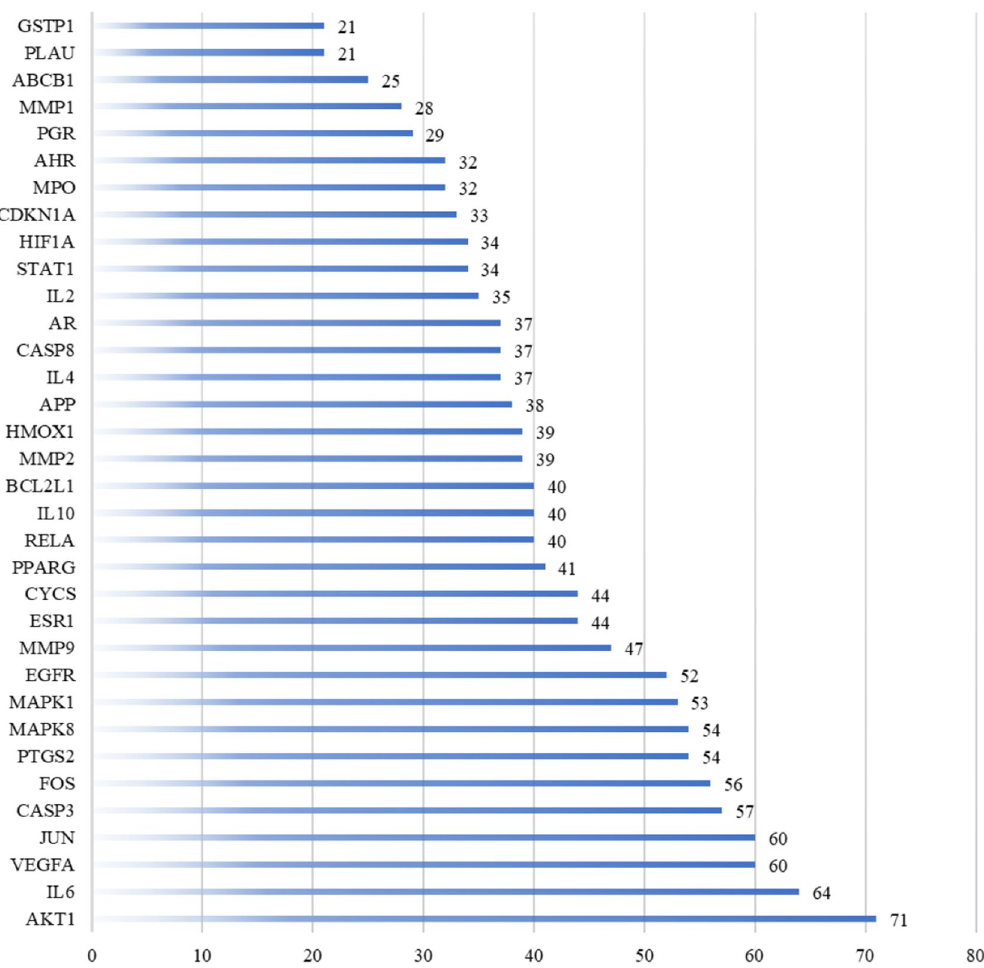
Figure 7. Degree centrality values of the core candidate Banxia-Xiakucao Chinese Herb Pair